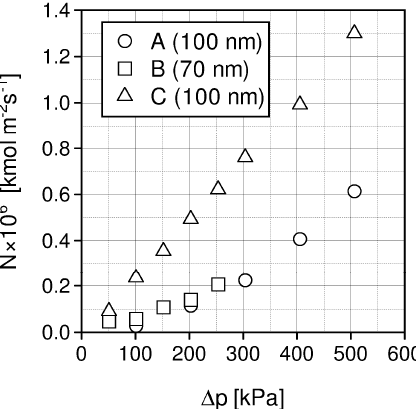
Figure 6. Comparison of CO 2 molar fluxes for SILMs based on membranes A, B and C impregnated with [Emim][Ac], temperature 20 °C.